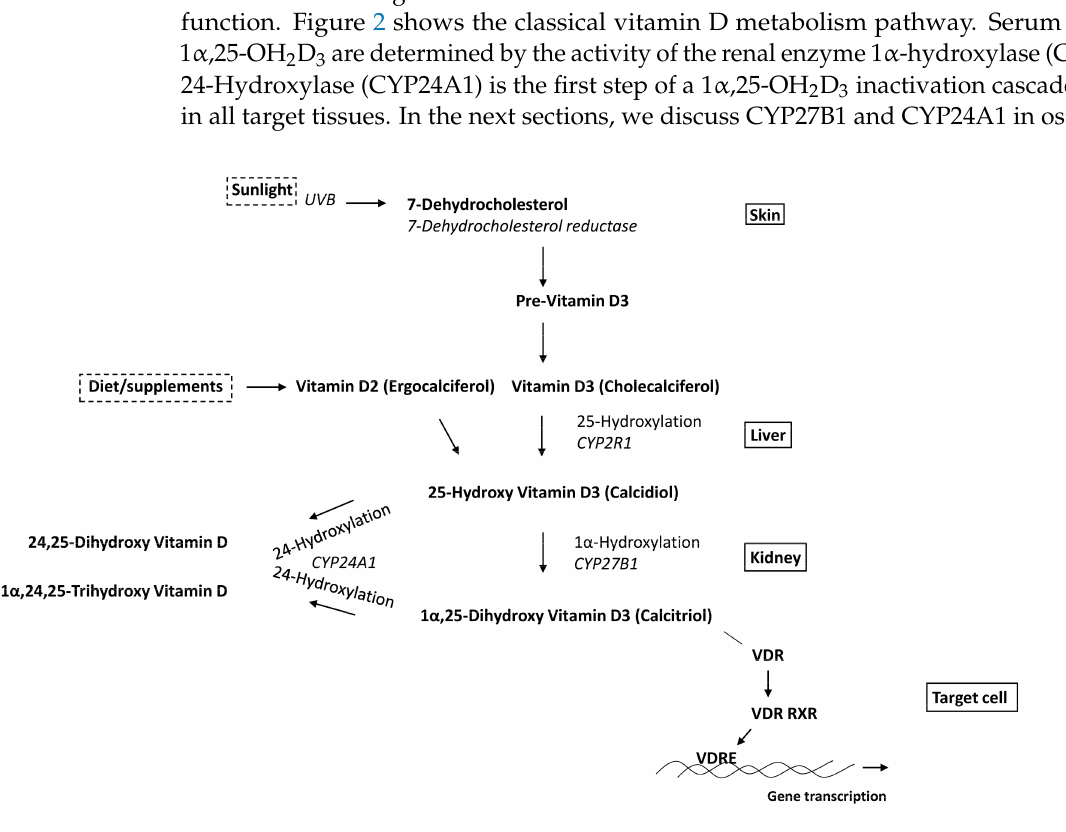
Figure 2. Schematic representation of classic vitamin D metabolism and signaling pathway.